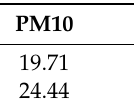
Figure 9. The solid line is the site data, and the dashed line is the experimental result of environmental measurement. Taking mean absolute error (MAE) and root mean square error (RMSE) as evaluation indicators, the smaller the value of the evaluation indicators, the smaller the error. The results are shown in Table 4. Table 4. Comparison of evaluation index